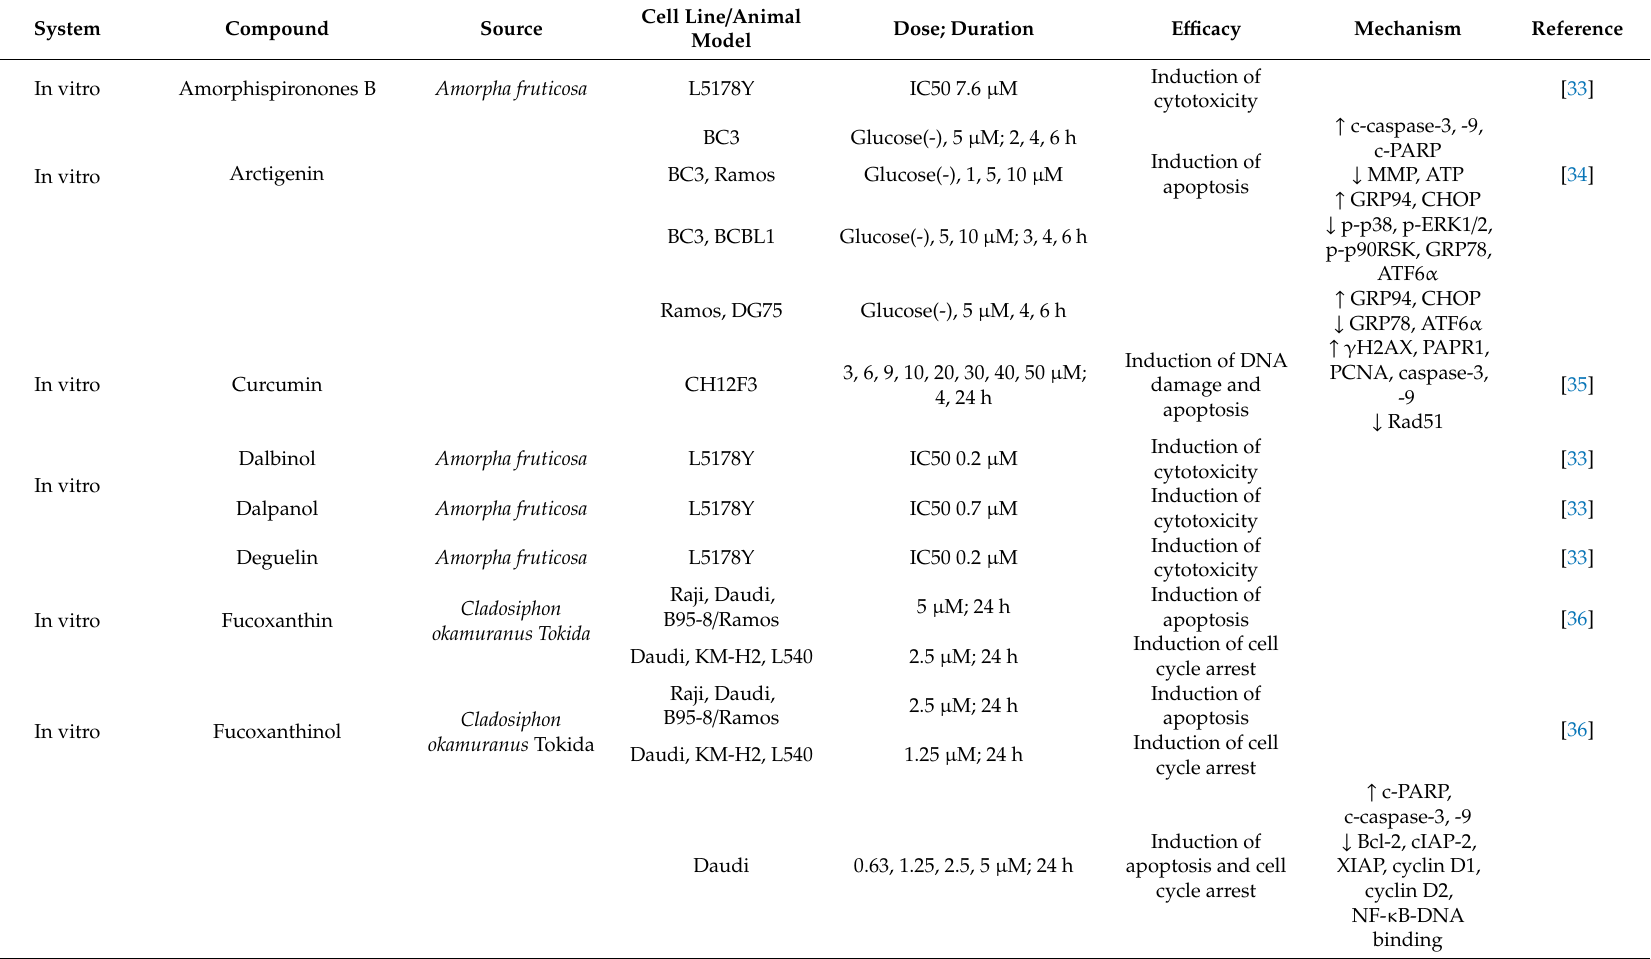
Table 2. Plant-derived compounds and